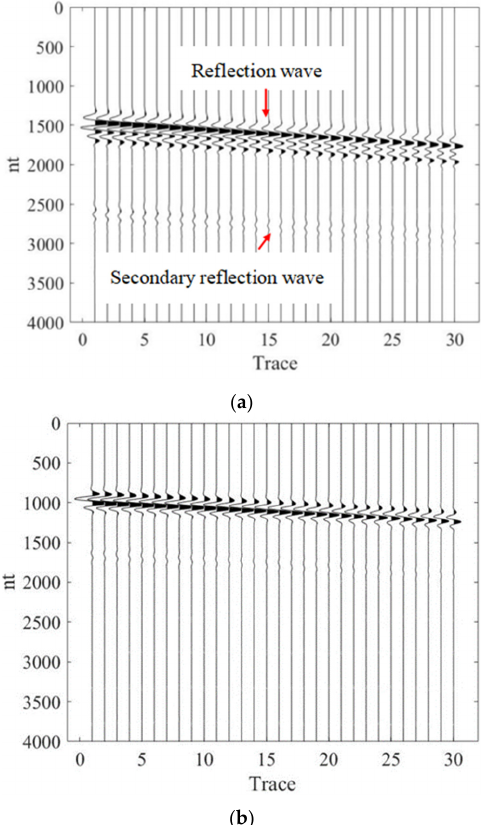
Figure 5. ( a ) Seismic records of CSP gathers of 90° lithologic interface numerical model in under- side wall. ( b ) Seismic records of CSP gathers of 45° lithologic interface numerical model in under- ◦ lithologic interface numerical model in underside side wall. wall. ( b ) Seismic records of CSP gathers of 45